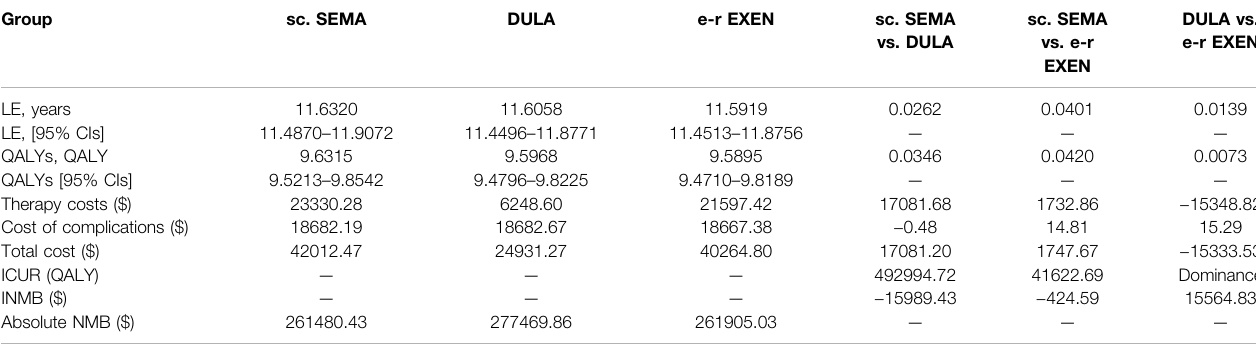
TABLE 6 | Long-term outcomes in the base-case cost-utility analysis. Group